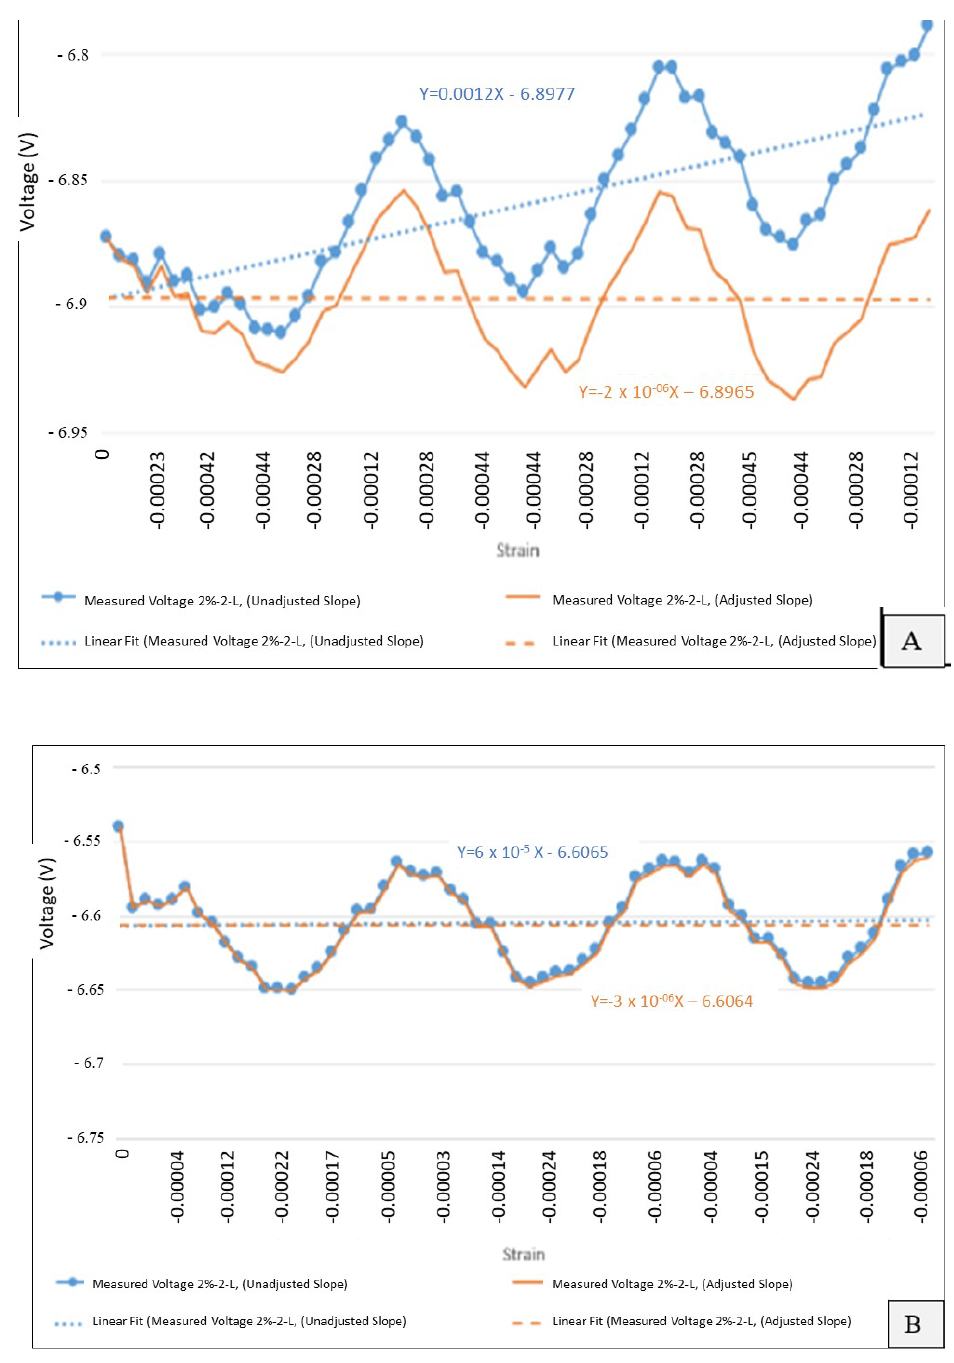
Figure 14. Skew in Voltage Measurements for Test 1 ( A ) and Test 2 ( B ).